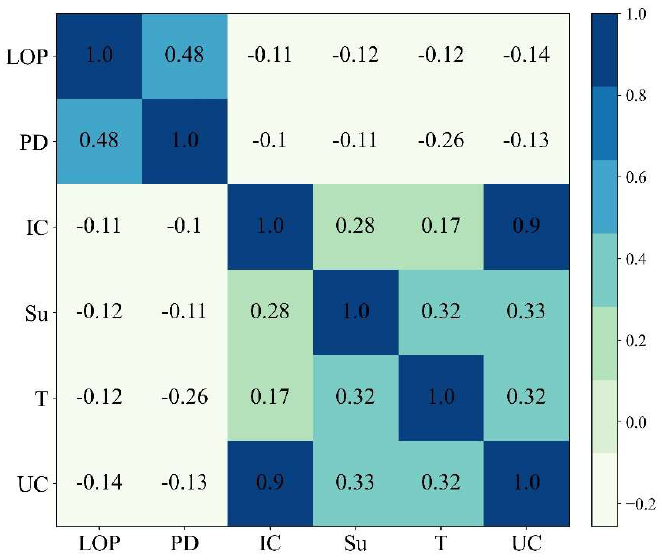
Figure 5. The heatmap of inputs and their correlations.